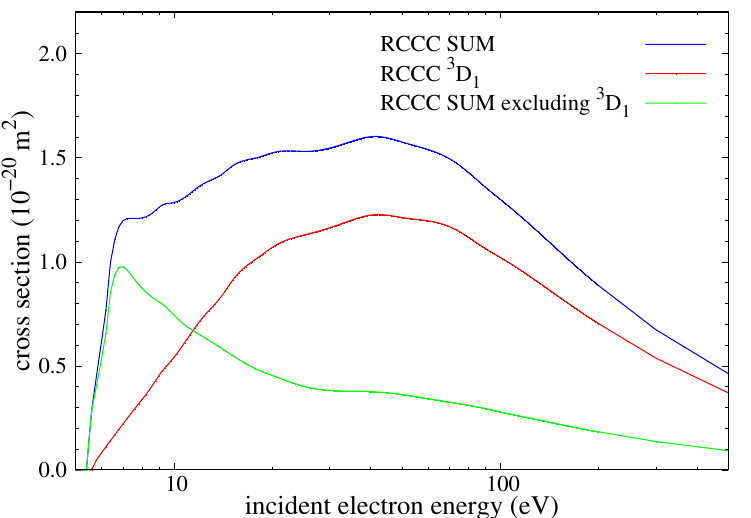
Figure 14. RCCC-integrated excitation cross sections to the 5 p 5 d manifold from the ground state. The blue line is the sum over all transitions to states in the manifold, the red corresponds to the dipole- allowed transition 5 p 2 3 P 0 5 p 5 d 3 D 1 and the green corresponds to the sum over all transitions, (cid:1) excluding the one to 5 p 5 d 3 D ○ 1